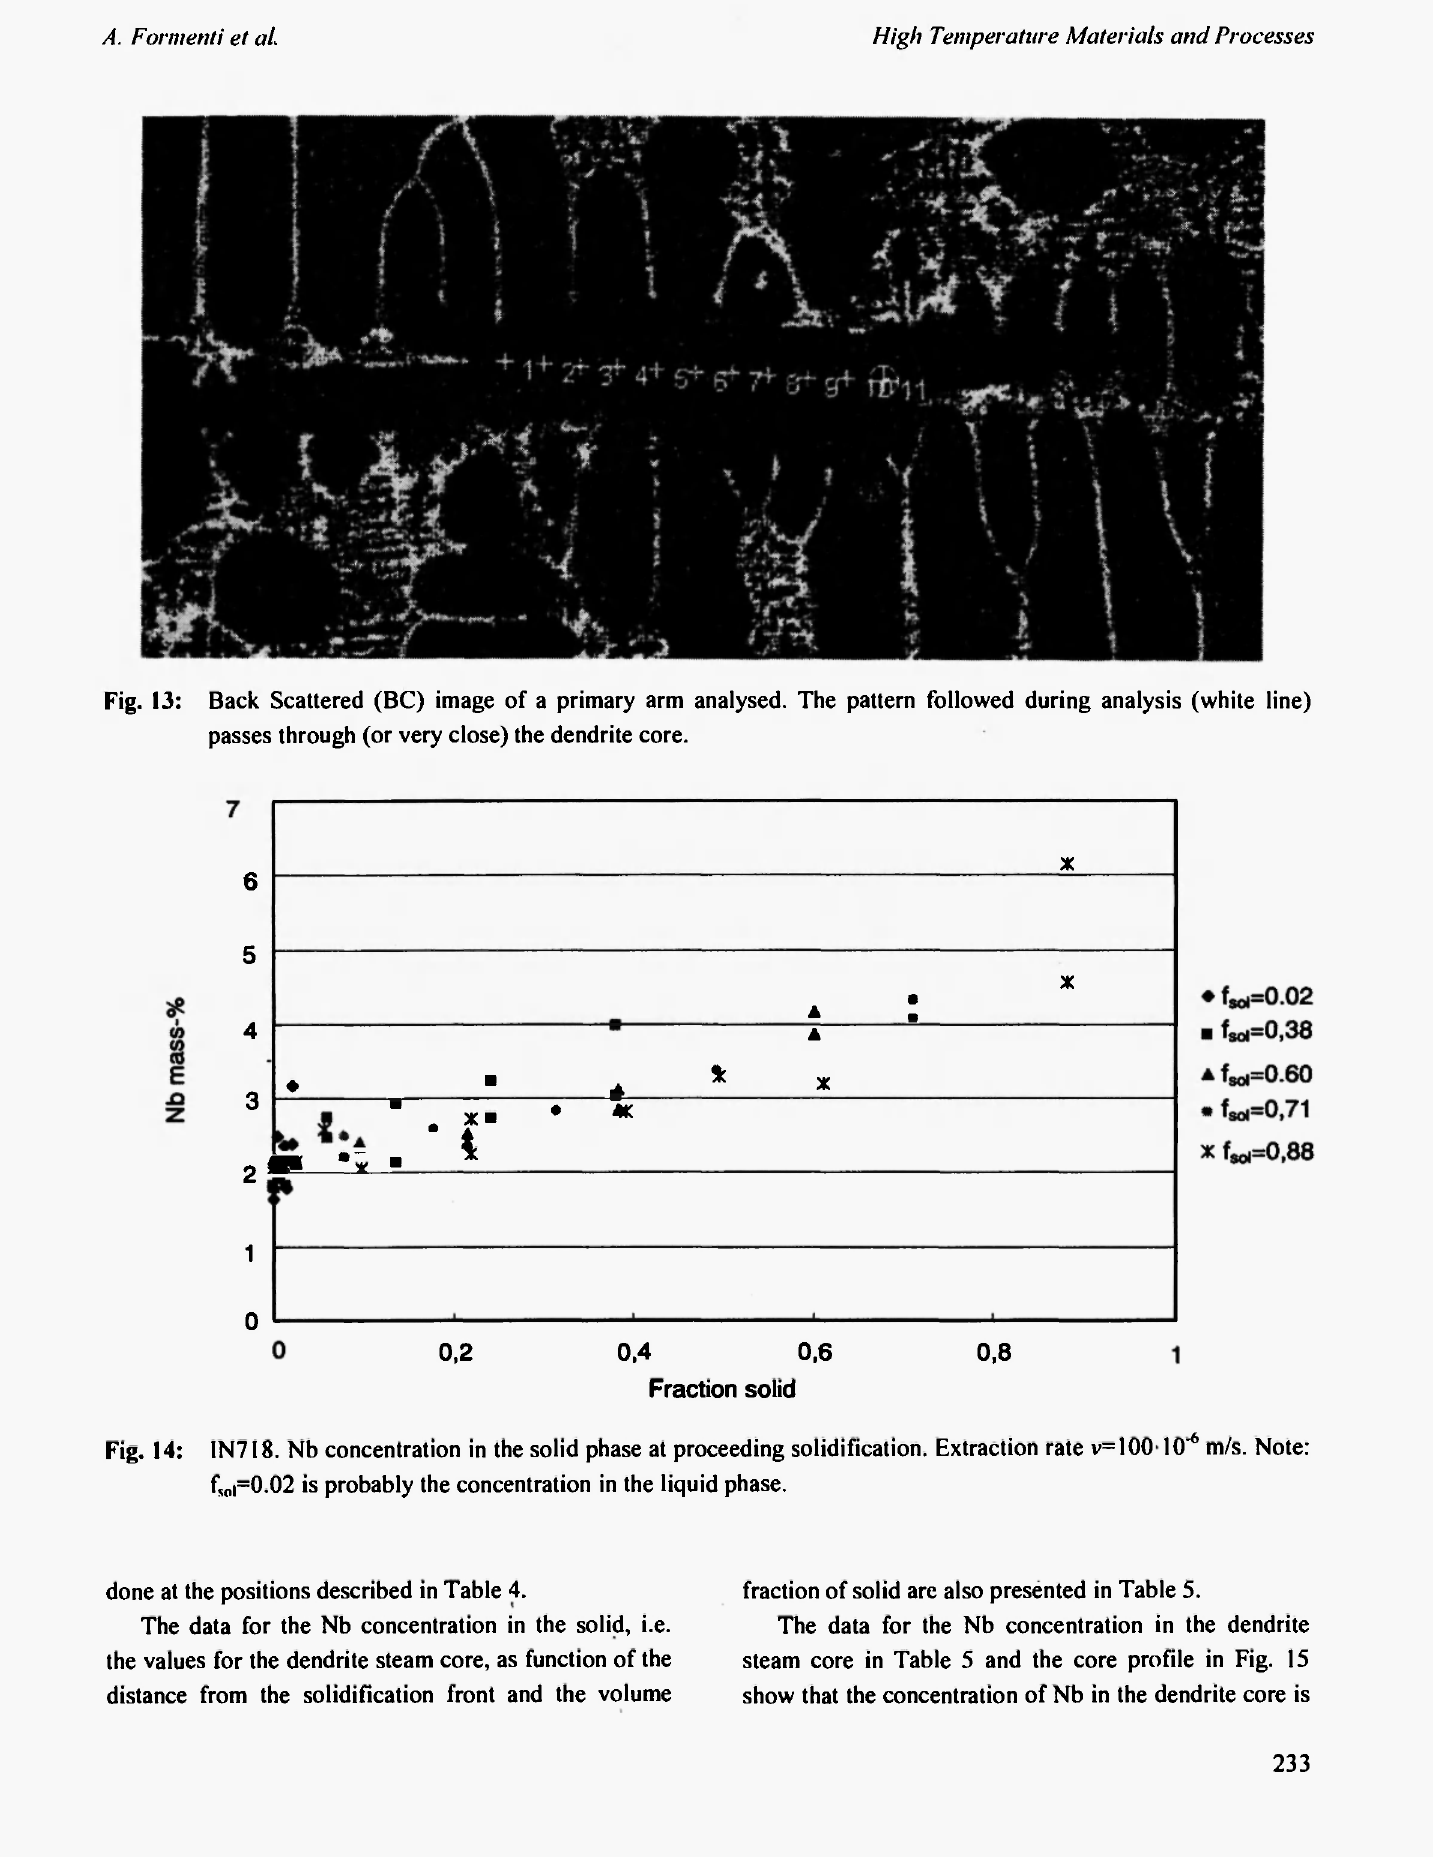
done at the positions described in Table 4. The data for the Nb concentration in the solid, i.e. the values for the dendrite steam core, as function of the distance from the solidification front and the volume